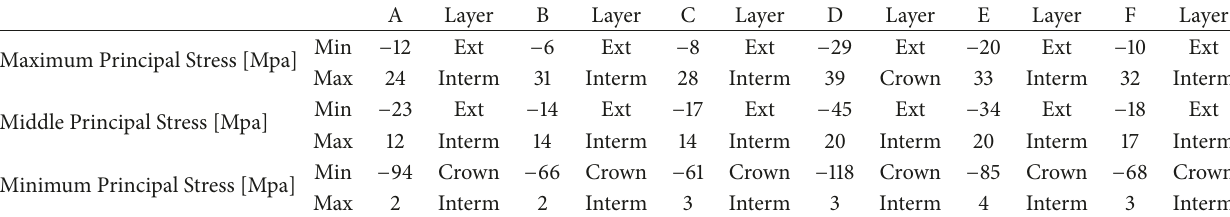
Table 4: Mechanical properties from compression tests ( 𝑛 = 10 for each material) and their hardness values of dental hard tissues and dental restorative